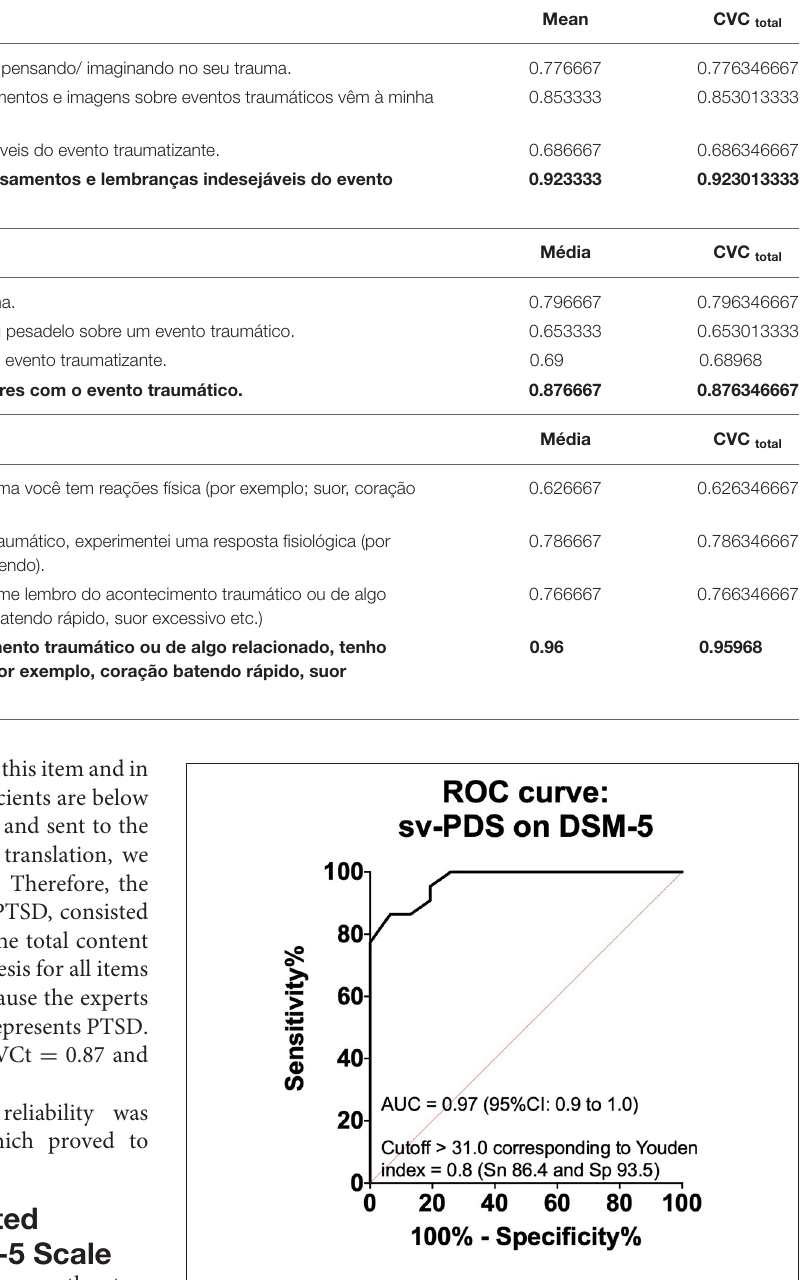
FIGURE 1 | Receiver operating characteristic (ROC) curve for sv-PDS (short version of the Posttraumatic Diagnostic Scale) for the diagnosis of